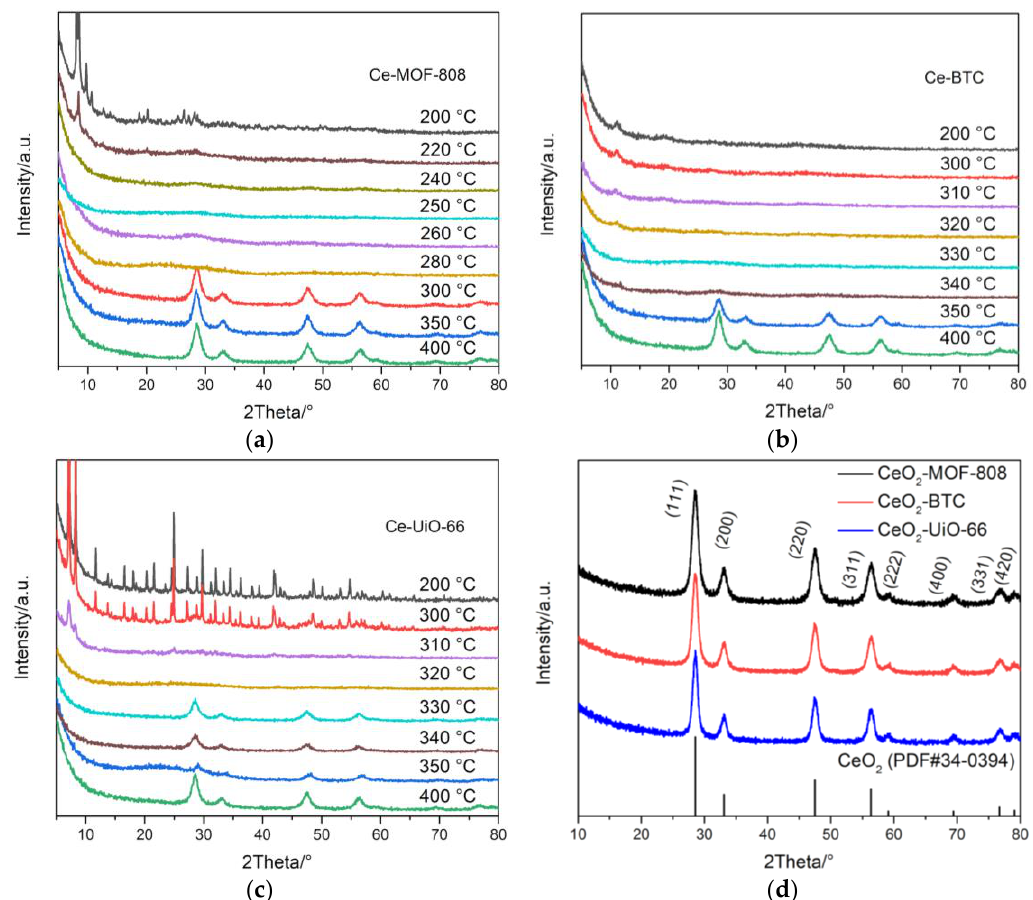
Figure 5. The PXRD patterns of ( a ) Ce-MOF-808, ( b ) Ce-BTC, and ( c ) Ce-UiO-66 at different Figure5. ThePXRDpatternsof( a )Ce-MOF-808, ( b )Ce-BTC,and( c )Ce-UiO-66atdi ff erenttemperatures, temperatures, and ( d ) the CeO 2 -MOFs after calcination at 500 °C. and ( d ) the CeO 2 -MOFs after calcination at 500 ◦